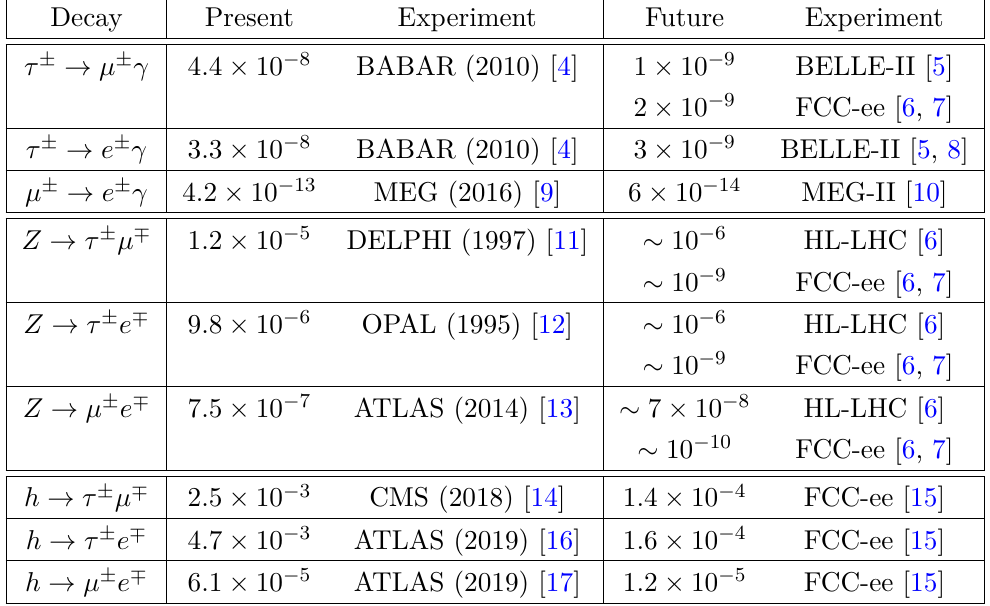
model with mass-insertion approximation concludes that the maximal decay rates are far from the current experimental bounds. The inverse seesaw model, a specific realization of low-scale seesaw models, might yield larger decay rates